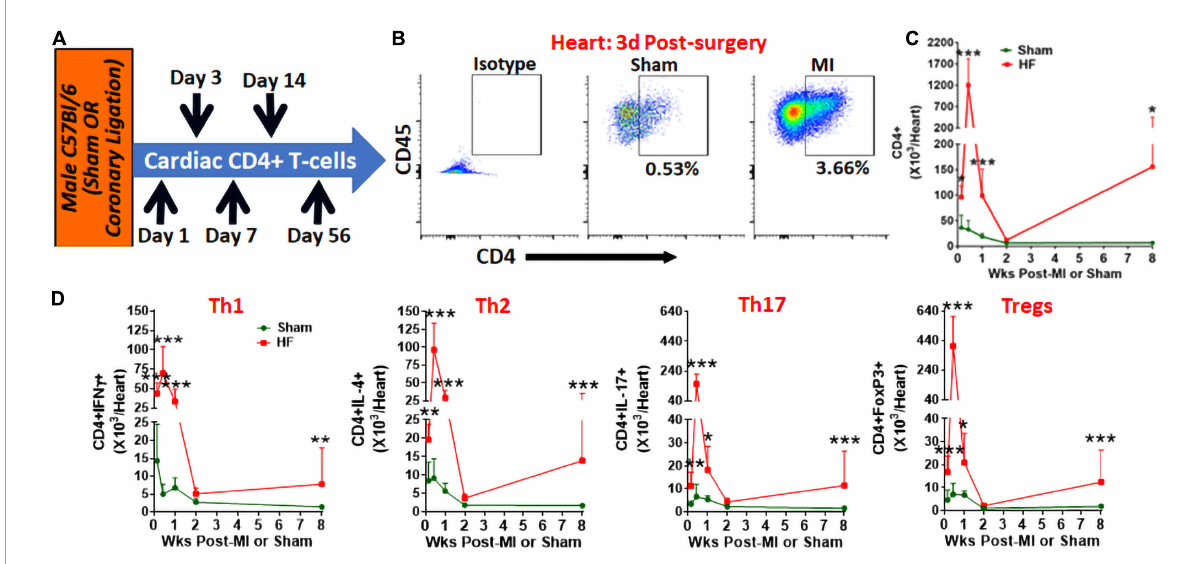
FIGURE1 (A) Schematic for the experimental protocol to measure cardiac CD3 + CD4 + T-cells post-MI. (B) Representative flow cytometry plots for cardiac CD45 + CD3 + CD4 + T-cells in sham and MI mice at 3 days post-surgery, and (C) their group quantitation at 1 days, and 3 days, and 1-, 2-, and 8-weeks post-MI. (D) Group quantitation for cardiac Th1 (CD3 + CD4 + IFN γ + ), Th2 (CD3 + CD4 + IL-4 + ), Th17 (CD3 + CD4 + IL-17 + ), and Tregs (CD3 + CD4 + FoxP3 + ) (8) at 1 day, and 3 days, and 1-, 2-, and 8-weeks post-MI. Data for 8 weeks has been shown previously (4). In the sham group n = 8, 5, 7, 5, and 7 whereas in the MI group n = 10, 5, 9, 5, and 10 at 1 day, 3 days, 1, 2, and 8-weeks, respectively, in (C,D) . Individual data points are not shown for clarity of trends. Data in (C,D) were analyzed using 2-way Anova with Bonferroni post-hoc test. * p < 0.05, ** p < 0.01, and *** p < 0.001 represent significance with respect to indicated